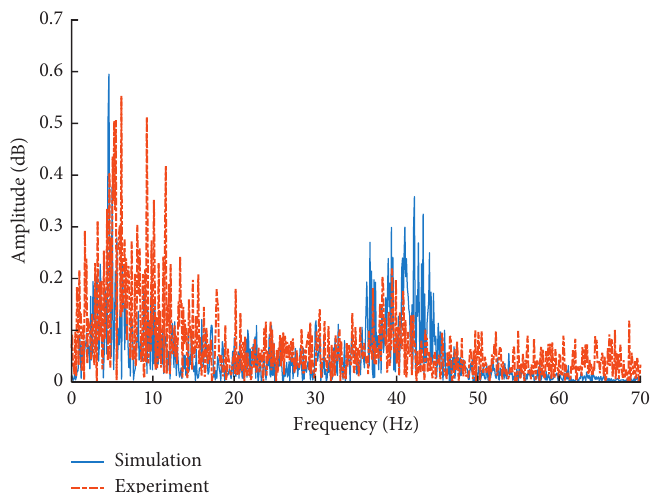
Figure 9: Comparison of unsprung mass vertical acceleration in the frequency domain.